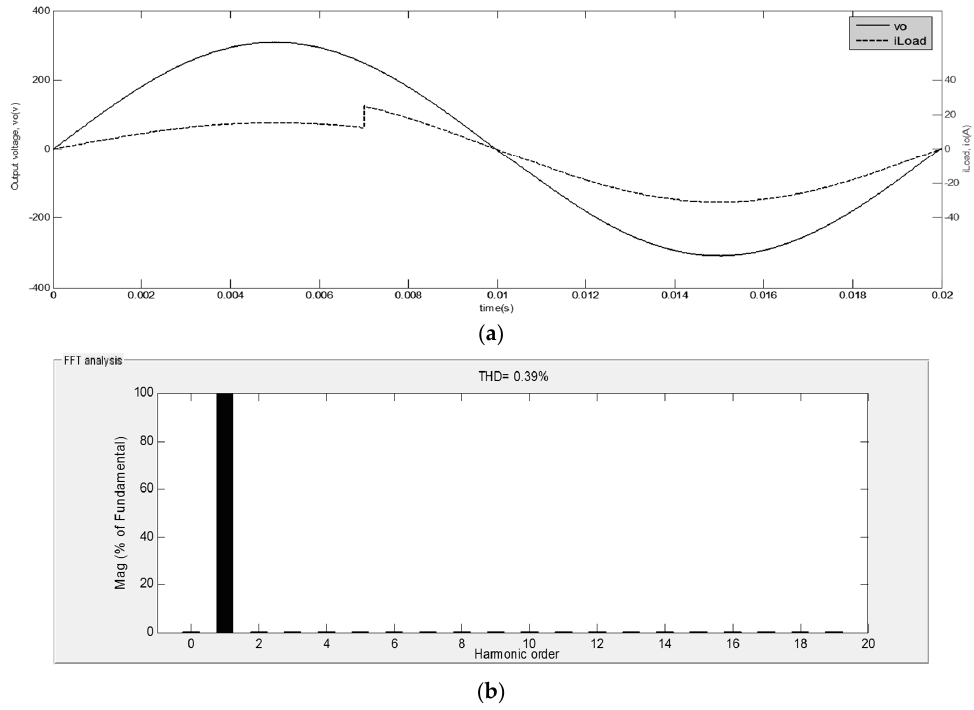
Figure 8. Simulation results for a dynamic change in the load resistance: ( a ) output voltage and load current for a dynamic change in the load resistance; and ( b ) the spectrum of the output for a dynamic change in the load resistance.